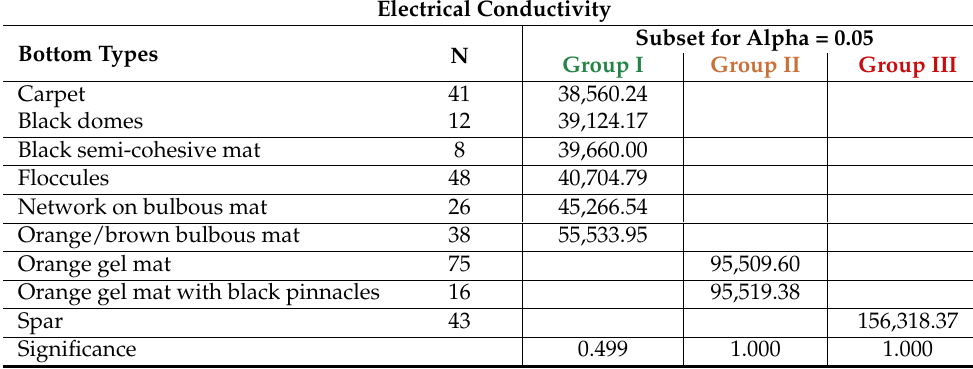
Table 1. Means for groups in homogeneous subsets of bottom types, based on electrical conductivity (EC, µ S cm − 1